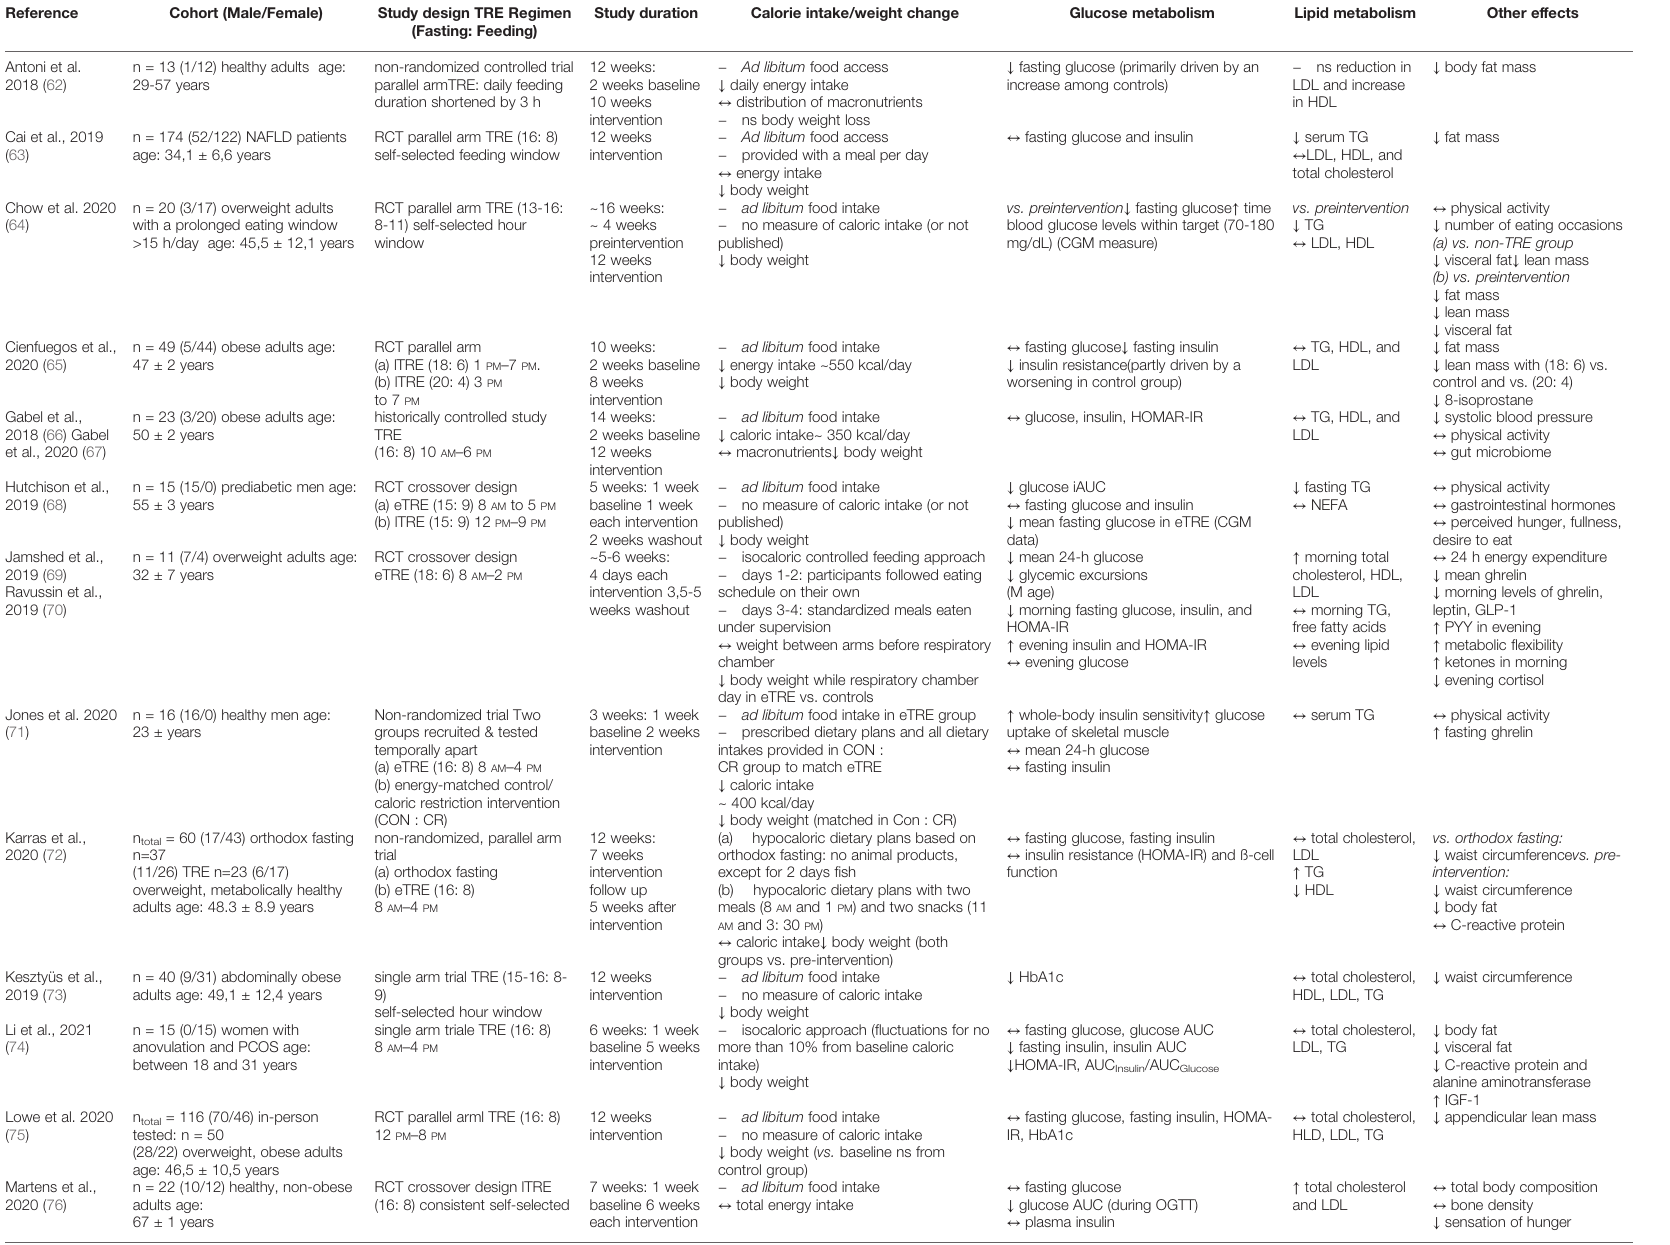
TABLE 1 | Clinical trials on TRE with outcomes regarding glucose and lipid